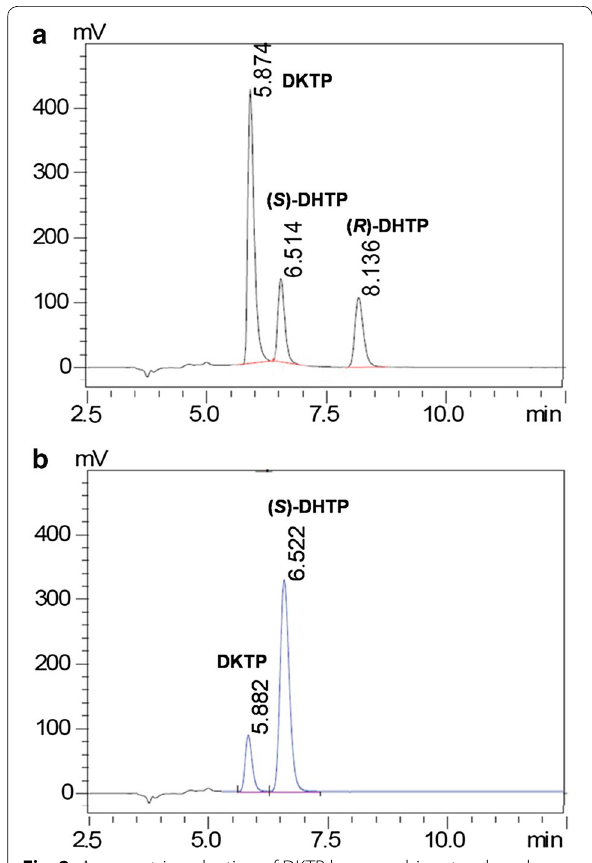
Fig. 2 Asymmetric reduction of DKTP by recombinant carbonyl reductase. a Standard samples of DKTP, ( S )-DHTP and ( R )-PED; b reac- tion